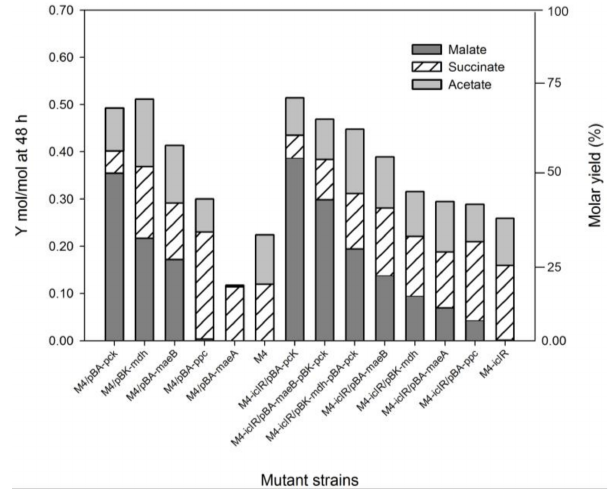
Figure 2. Cumultive bar charts of C4 metabolites and acetate molar yields in mol/mol ( Y right axis) and molar yields in % ( Y left axis) of overexpression and co-expression on M4 and M4- ∆ iclR strains at 48 h. Standard deviation for all parameters was <0.04.